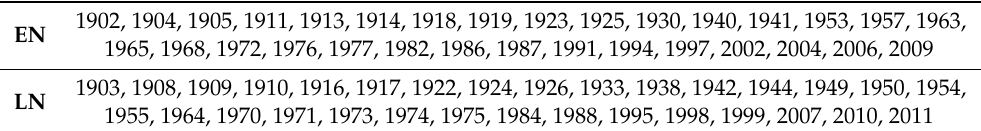
Table 1. EN and LN onset years during the 1901–2014